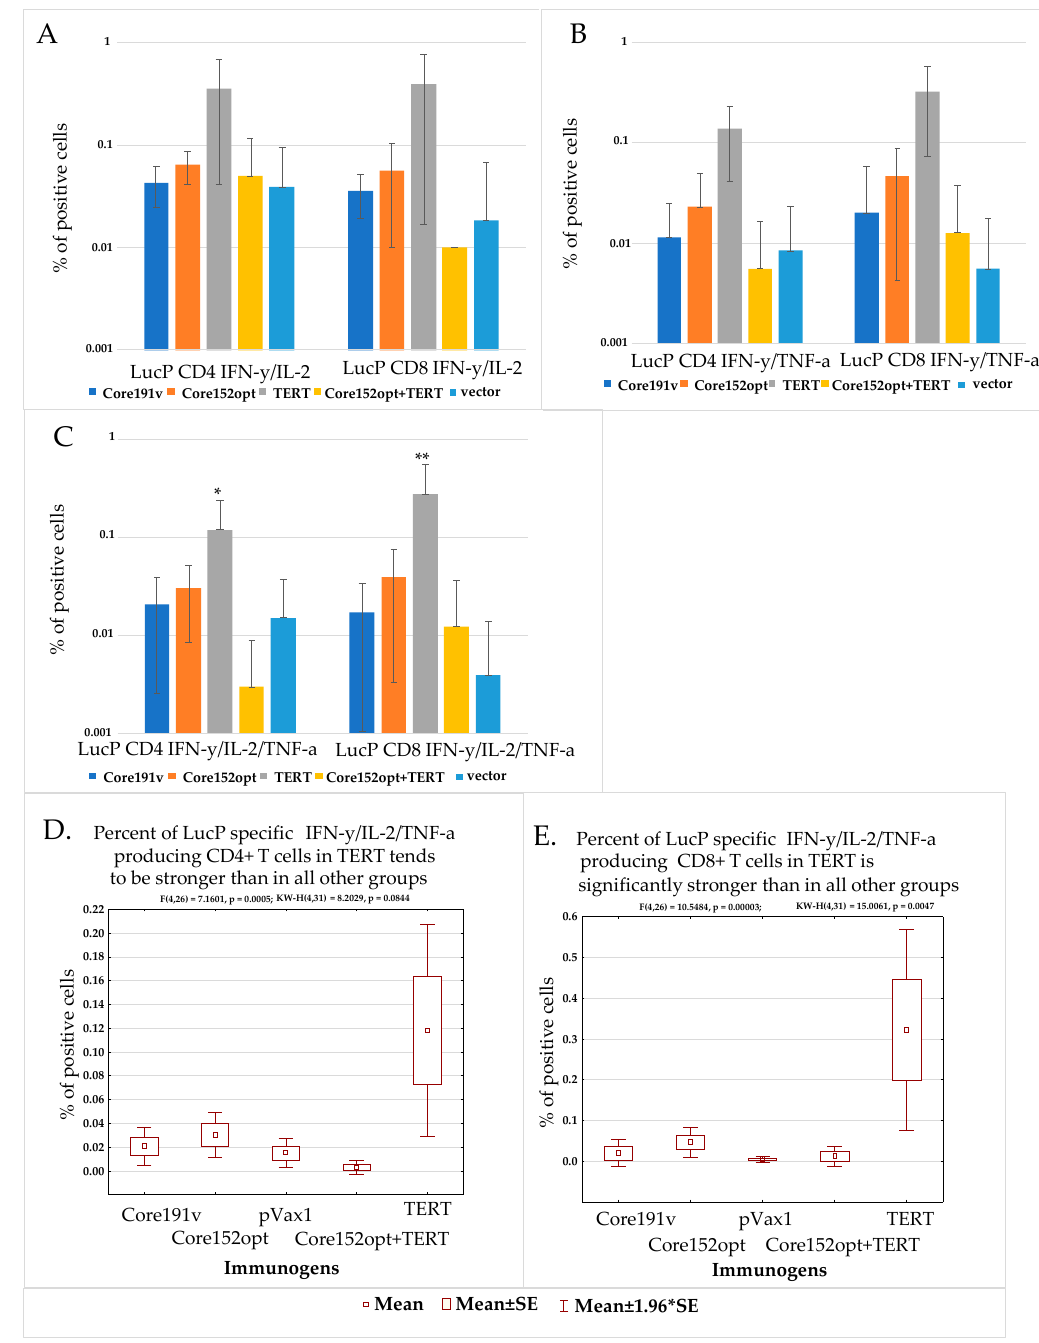
Figure 6. T cell response to immunodominant epitope at aa 166-168 of luciferase (LucP) in mice DNA immunized with Core191v, Core152opt, TERT, Core152opt/TERT mix or empty vector. Data from immunization series I and II; for vector mice, combined data from series I and II (Table 1). Percent CD4+ and CD8+ T cells secreting IFN- γ /IL-2 ( A ), IFN- γ /TNF- α ( B ), IFN- γ /IL-2/TNF- α ( C ); Statistical comparison of % IFN- γ /IL-2/TNF- α secreting CD4+ ( D ) and CD8+ T cells ( E ). Panels A-C, average ± STDV; D, E, mean ± standard error (ER). No difference between the groups in populations of IFN- γ /IL-2, and IFN- γ /TNF- α CD4+ and CD8+ in Kruskal Wallis test, and pairwise comparisons in Mann-Whitney U -test ( A , B ). ** p < 0.05, * p < 0.1, in pairwise comparison between mice DNA immunized with TERT versus other groups, Mann-Whitney U test ( C ) (Statistica Tibco, version 13.5).